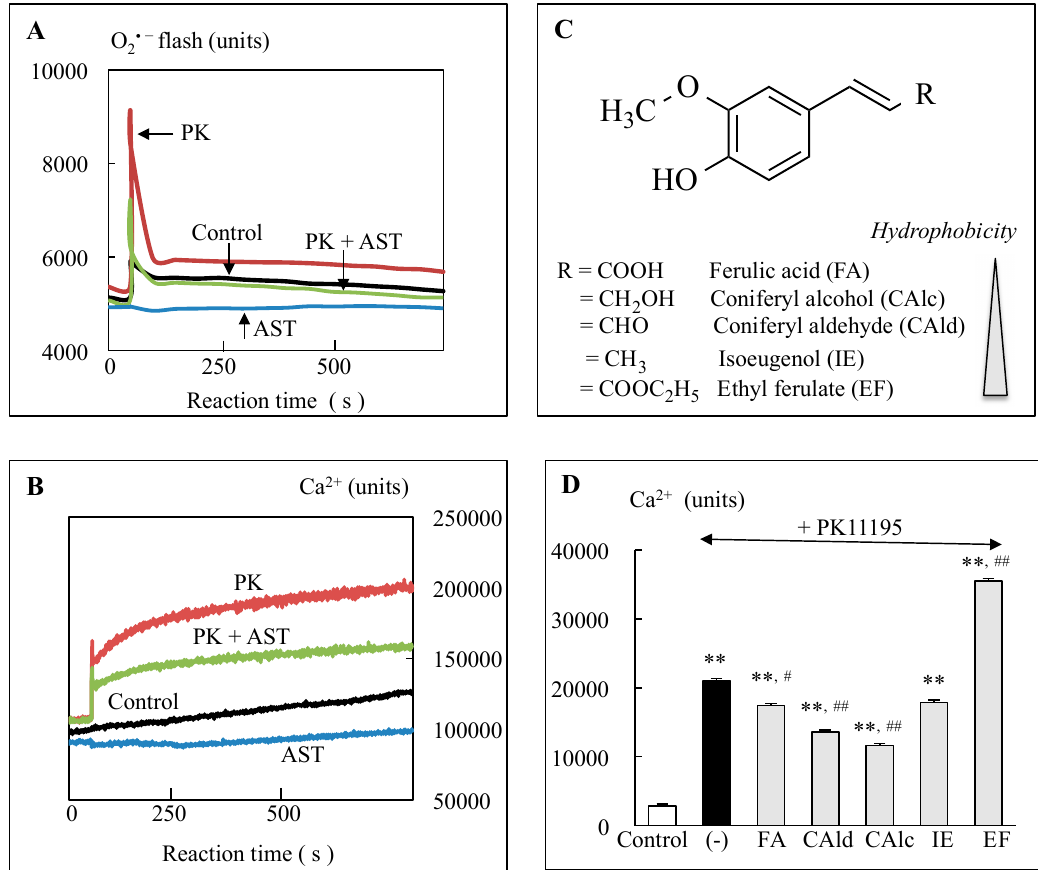
Figure 5. Phytochemicals inhibited or promoted the mitochondrial permeability (mPTP) opening. A and B . Astaxanthin (AST) inhibited the PK11195-induced mPTP, which was detected as superoxide flash ( A ) and Ca 2+ efflux ( B ). PK, AST and PK + AST: SH-SY5Y cells treated with PK11195, AST, and cells pretreated with AST then PK11195. C . Chemical structures of ferulic acid derivatives, which